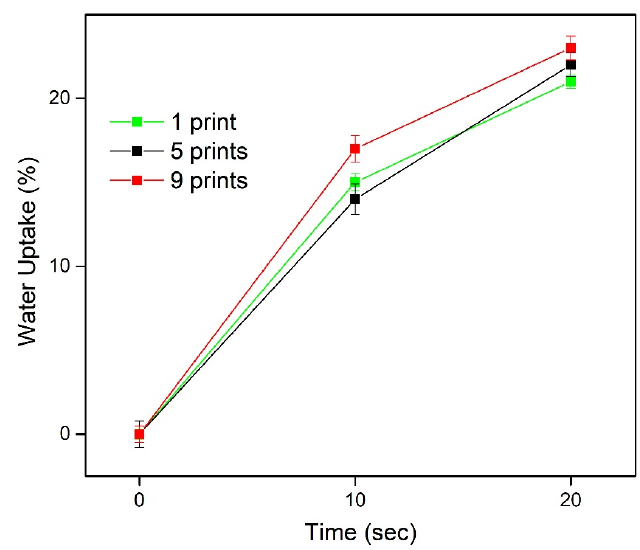
Figure 1. Water uptake of 1, 5, and 9 times printed films.